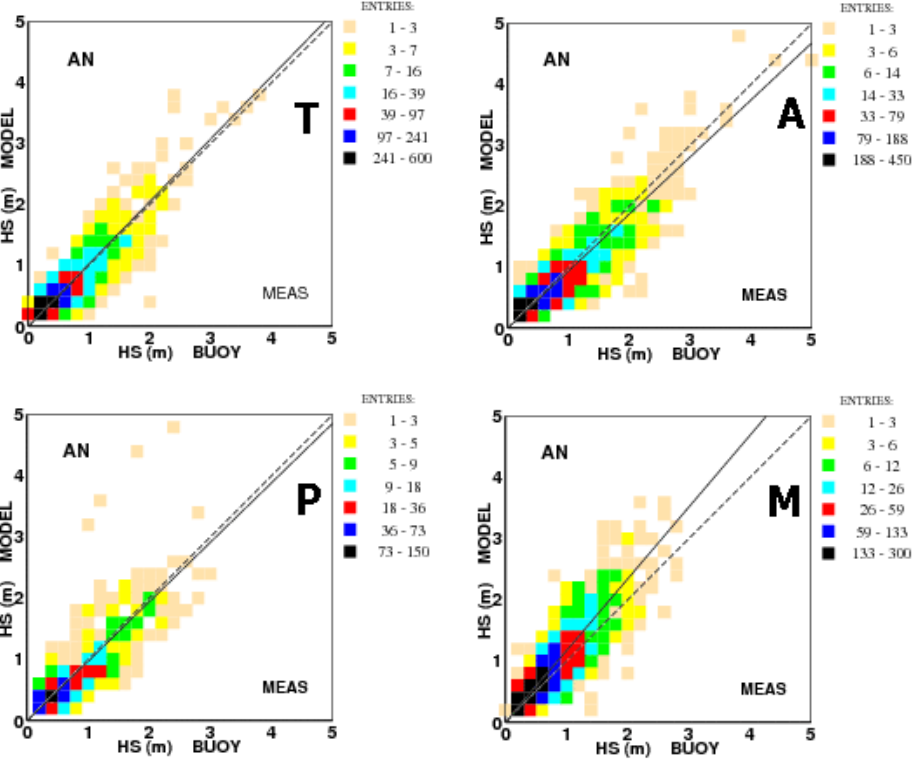
Fig. 9. Scatter diagrams of the model significant wave heights (analysis) vs the corresponding measured data at the ISMAR oceanographic tower (T) and the (A=Ancona), (P=Pescara), (M=Monopoli) wave measuring buoys. The period considered is 2010.